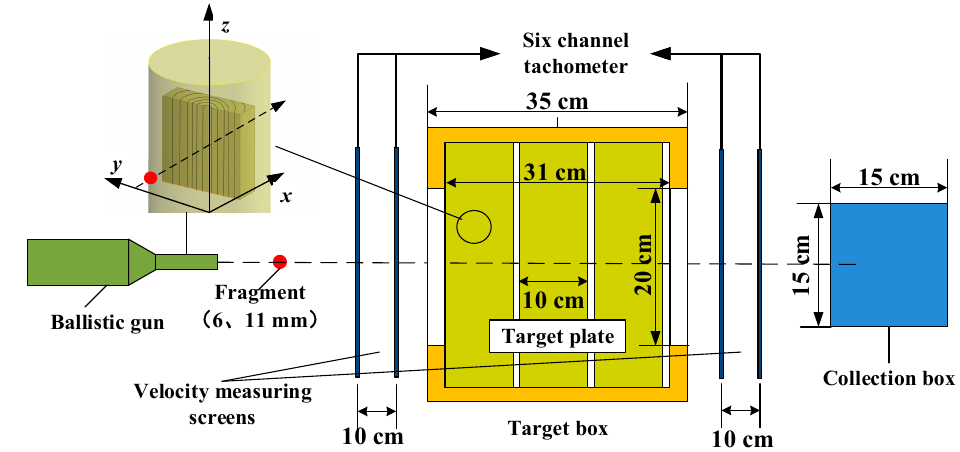
Figure 1. Schematic diagram of penetration test scheme.